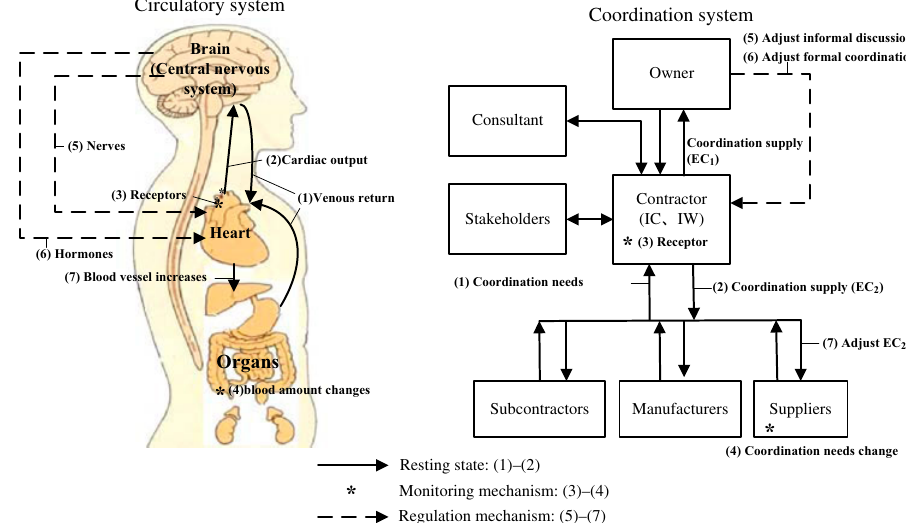
Fig. 1. Comparisons between circulatory system and coordination